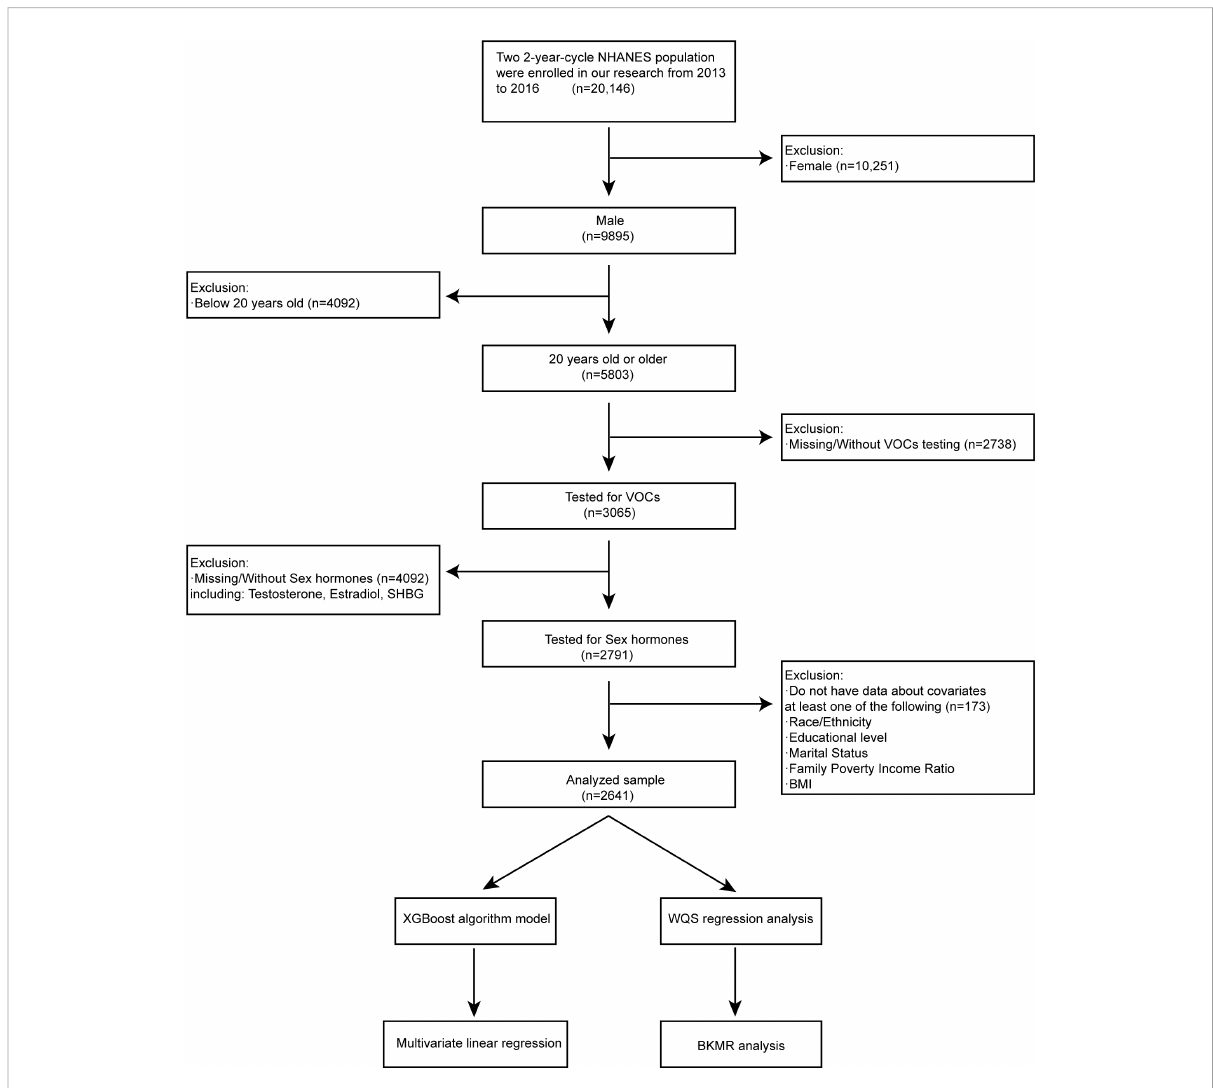
FIGURE 1 Flowchart of studied participants selection (N=2641) and analysis process, NHANES, USA,